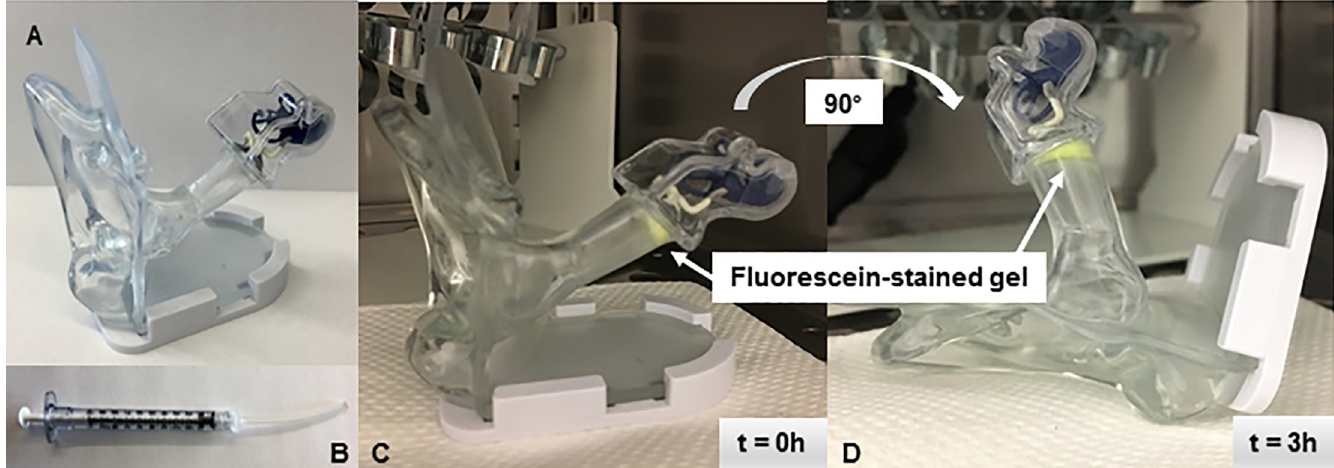
Fig 3. Model of drug delivery system retention. Administration of 100 μ L gel/MS suspension (gel stained with fluorescein for visualization) to TM in synthetic human ear model (A) using a modified syringe applicator (B). Retention was confirmed after 3 hours inversion (C,D).